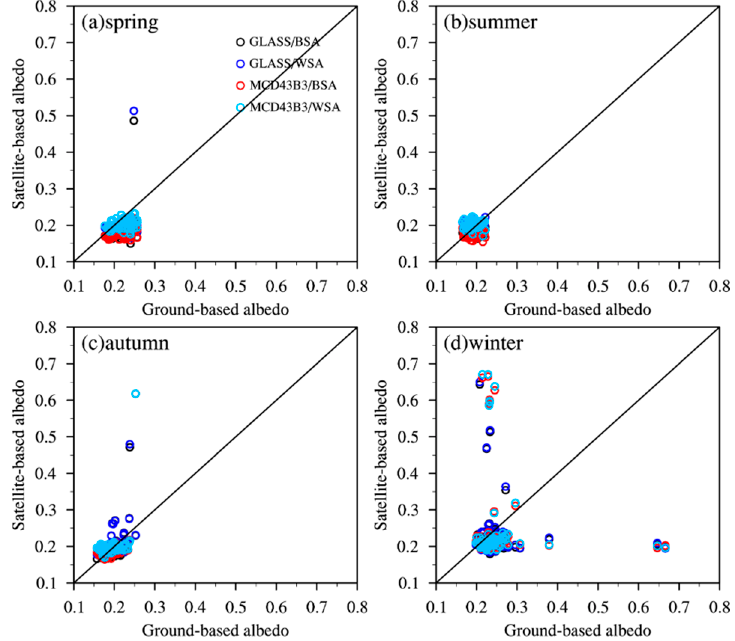
Figure 5. Scatter plots of seasonal changes in albedo for GLASS, MCD43B3, and ground-based at Maqu site over the years during ( a ) spring, ( b ) summer, ( c ) autumn, and ( d )